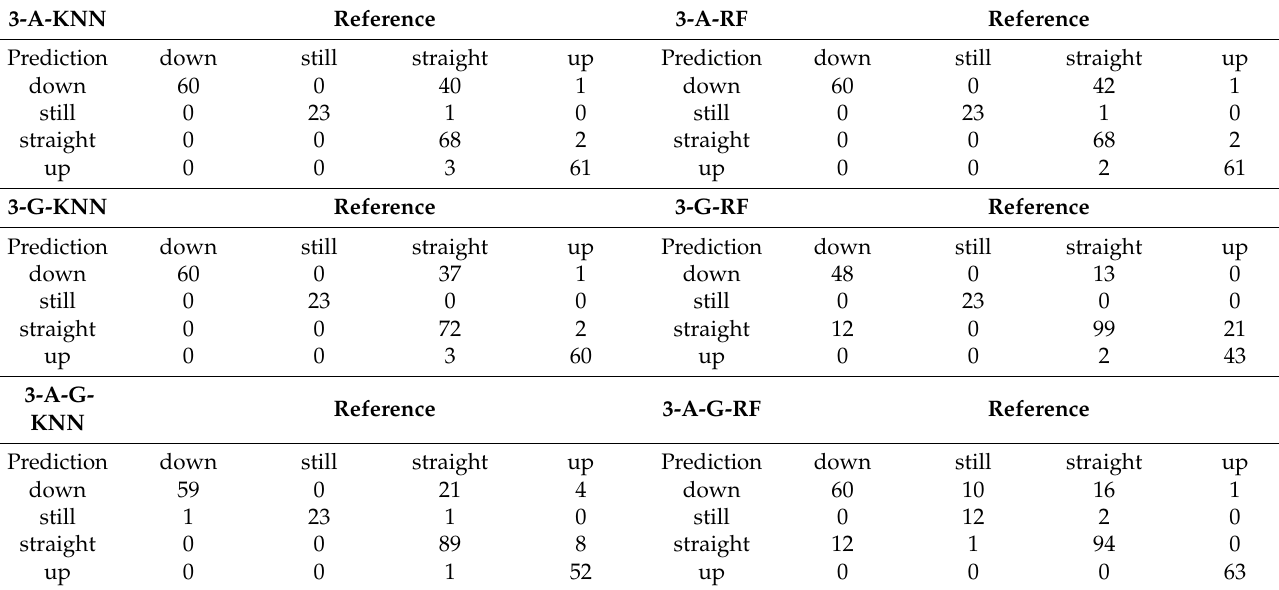
Table 1. No. 3 sensor hoisting activity recognition